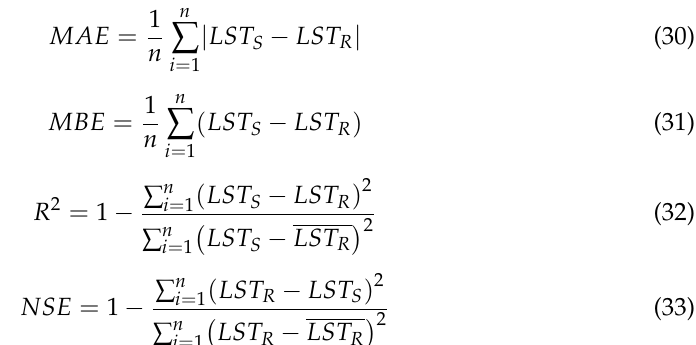
Table 5. Pearson correlation coefficients between features and LST.